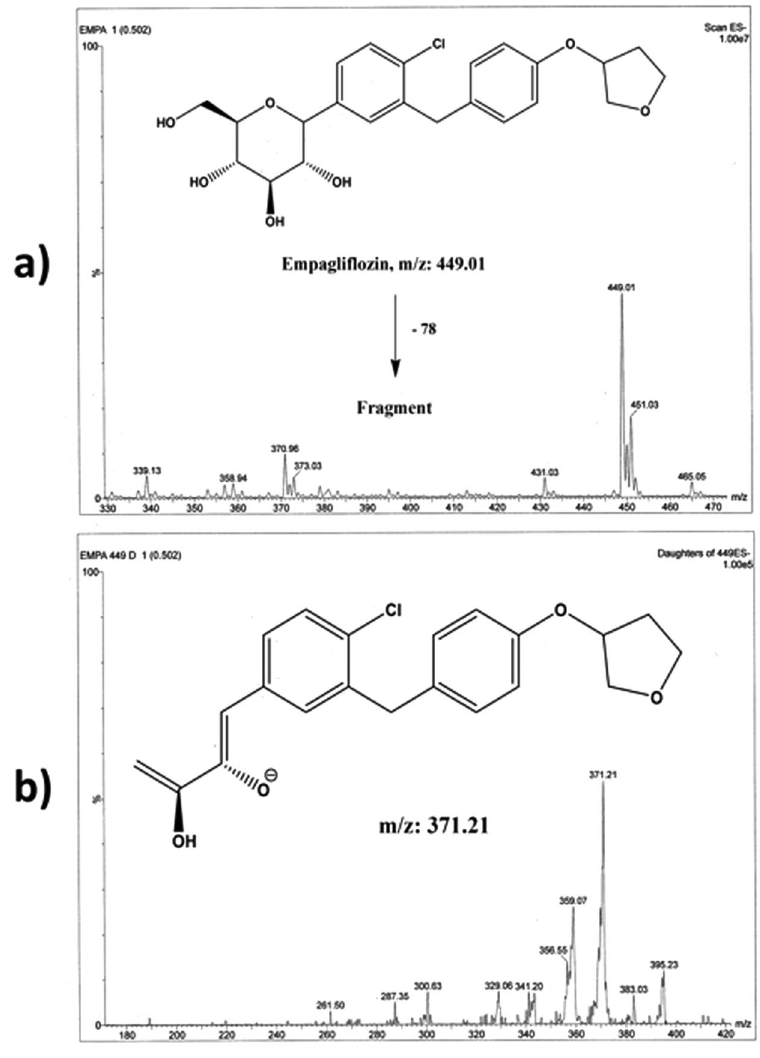
Figure 2. Full scan mass spectrum ( a ) and daughter ion mass spectrum ( b ) of empagliflozin in negative ESI ion detection mode with the proposed